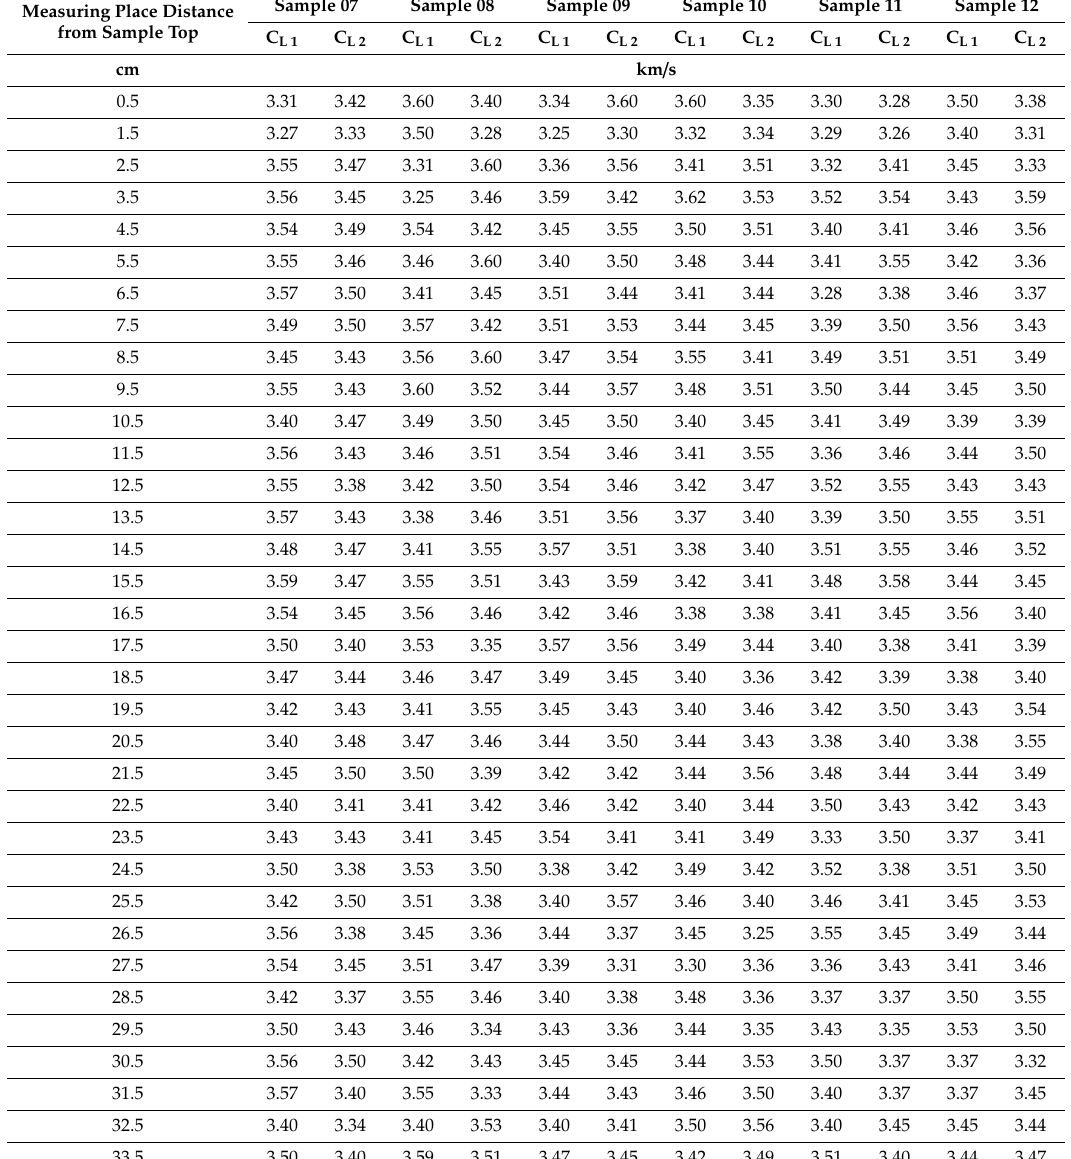
Table 3. Velocities C L of longitudinal ultrasonic wave propagation, measured in two perpendicular directions in core samples taken parallel with the top surface of the